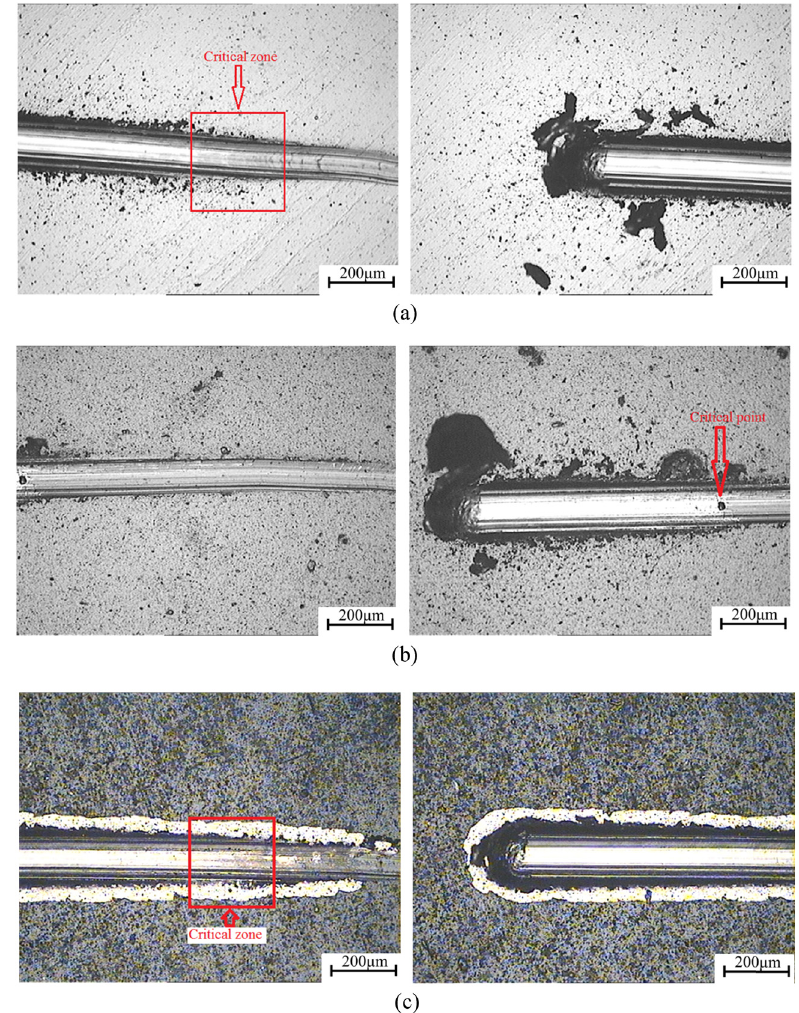
Figure 4: Scratch morphologies of ( a ) TiN coating, ( b ) TiAlN coating, ( c ) TiAlCrN